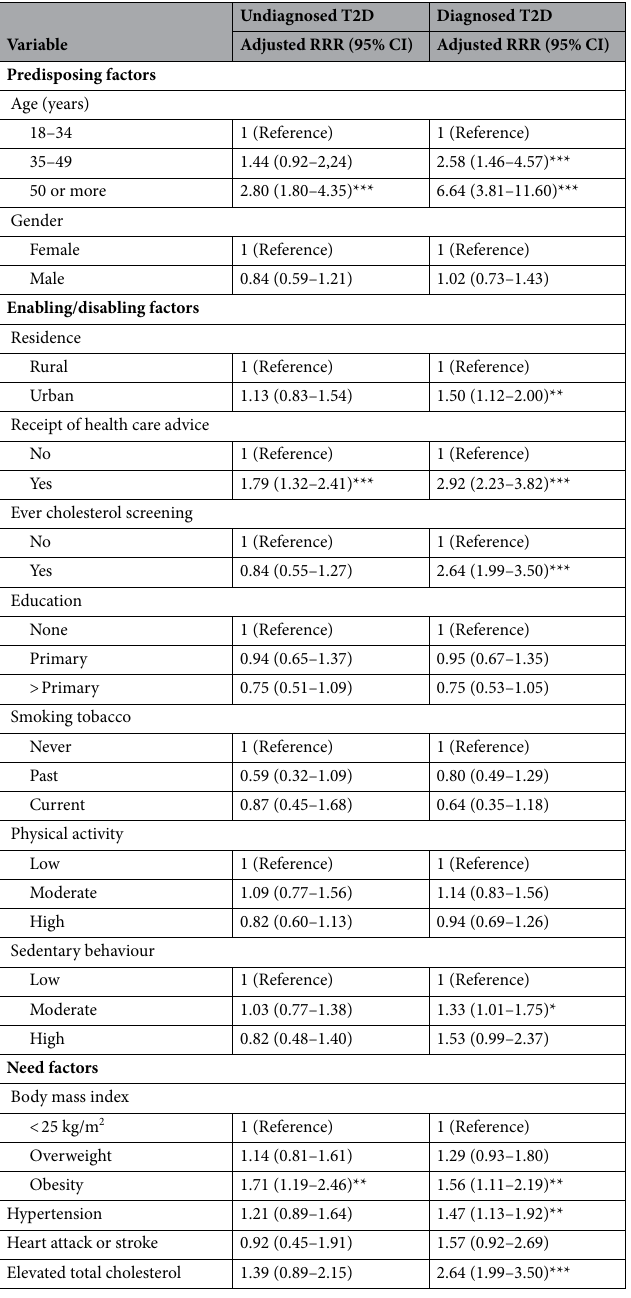
Table 3. Relative risk ratios for factors associated with undiagnosed and diagnosed type 2 diabetes (T2D) in Moroccan adults, 2017, adjusted for age, gender, RRR Relative risk ratio, CI Confidence intervals. * p < 0.05; ** p < 0.01; *** p <